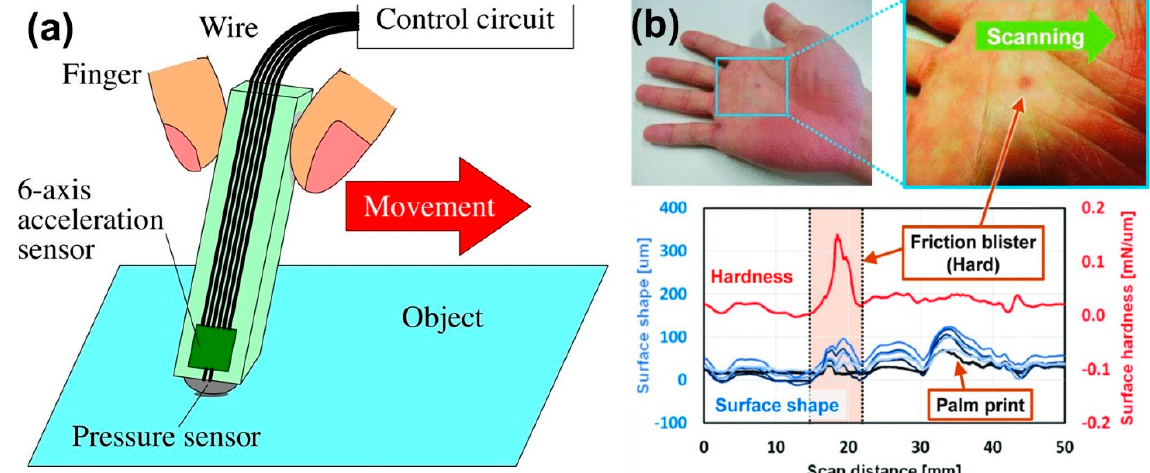
Figure 14. ( a ) Pen type pressure sensor for surface texture and softness detection. ( b ) Measurement results of friction blister on the subject's palm and comparison of surface shape signal and hardness results of friction blister on the subject’s palm and comparison of surface shape signal and hardness signal. Reprinted/adapted with permission from Ref. [118]. Copyright 2021, IEEE. signal. Reprinted/adapted with permission from Ref. [118]. Copyright 2021,